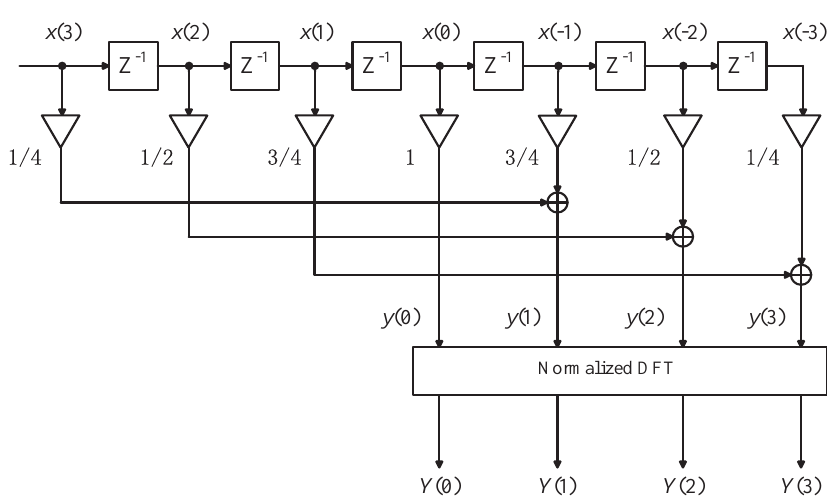
Figure 1. Simplified flow diagram of phase corrected DFT ( N =